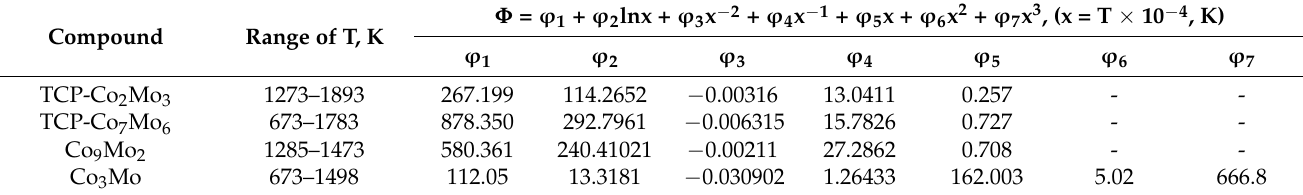
Table 3. Coefficients of the polynomial of the reduced Gibbs energy (J/(mol K)). Compound Range of T,